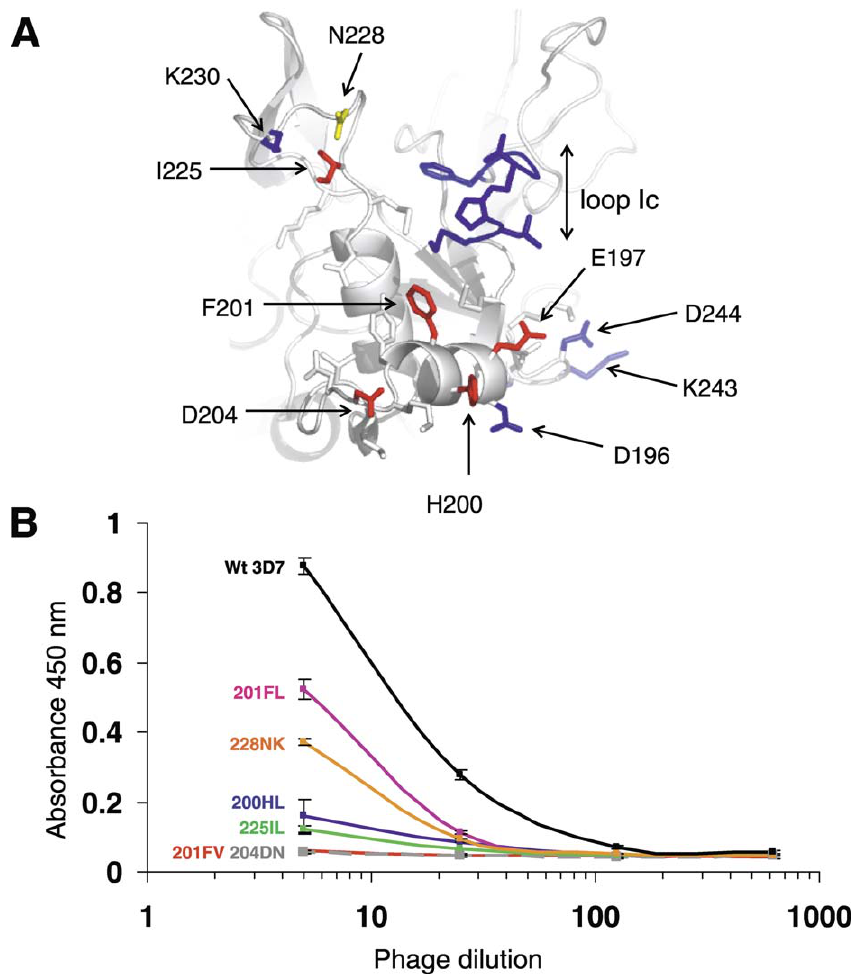
Figure 3. Effect of AMA1 Mutations on 1F9 Binding (A) Mapping of point and deletion mutations onto the AMA1 structure. Point mutations at positions 197, 200, 201, 204, and 225 (coloured red) disrupted 1F9 binding. Point mutations at position 228 (yellow) were partially disruptive. Point mutations at positions 196, 230, 243, and 244 (blue) had no effect on 1F9 binding. N-terminal deletion of loop Ic (blue) had no effect on binding [38]. (B) M13 phage expressing point mutations in domain I AMA1 were added to immobilized 1F9 at a series of dilutions. Bound phage were assayed by the addition to peroxidase-conjugated anti-M13 mAb followed by a colourimetric assay. Assays were carried out in duplicate and the error bars indicate the two measured absorbance